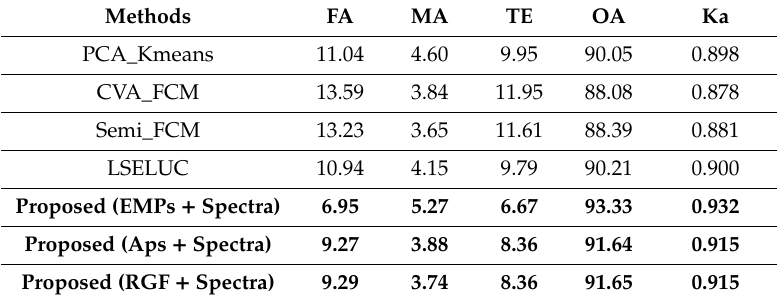
Figure 6. Change detection maps obtained for the Site B landslide aerial images through ( a ) PCA_kmeans; ( b ) CVA_FCM; ( c ) Semi_FCM; ( d ) LSELUC; ( e ) Proposed_EMPs+Spectra; ( f ) Proposed_APs+Spectra; ( g ) Proposed_RGF+Spectra; and ( h ) ground refence map. Table 7. Quantitative comparisons (%) between the proposed approach and state-of-the-art methods for Ji’Nan QuickBird satellite images.